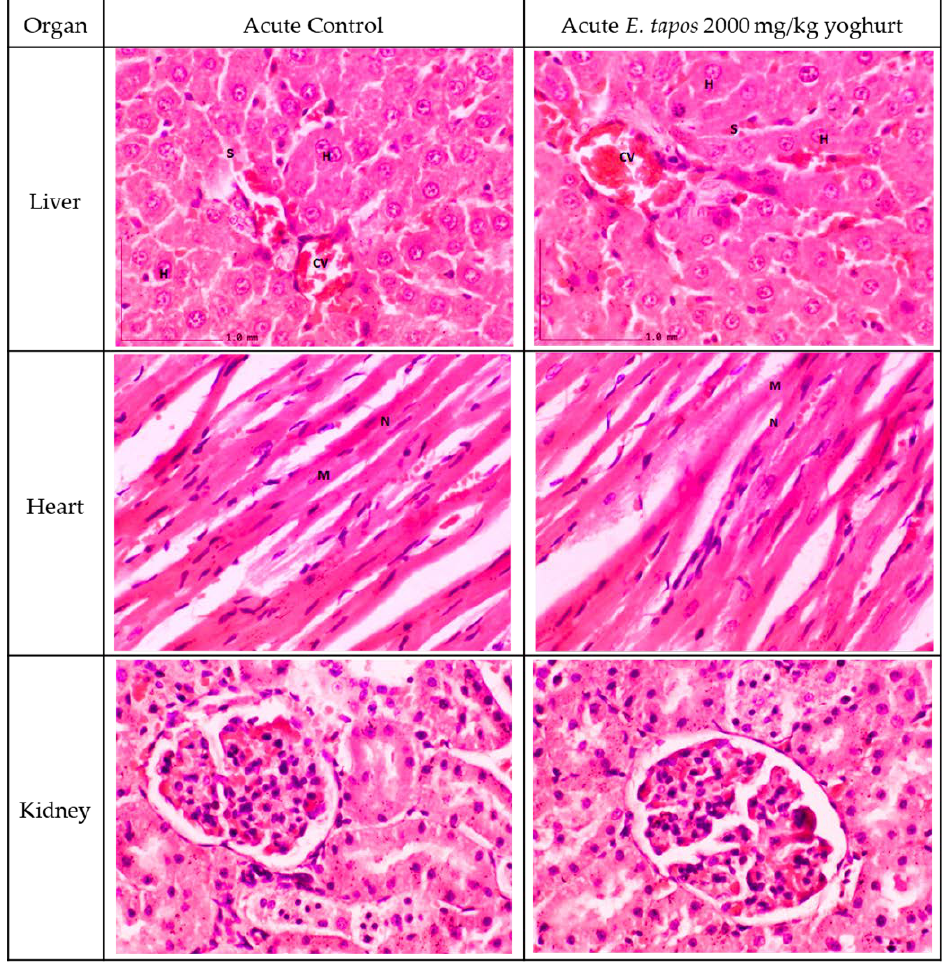
Figure 1. Histology section of acute toxicity study. The liver section shows standard strands of hepatocytes (H), sinusoids (S), and central vein (CV). It shows 0% of biopsied hepatocytes affected. The liver grading score was recorded as 0 due to absence of steatosis, lobular inflammation, and hepatocyte ballooning. The heart histological section shows normal heart architecture, and no inflammation was observed. Myocardium (M) and nucleus (N). The kidney histology showed no abnormal lesion or tubular dilation. Renal corpuscle appeared normal. No abnormalities were observed in kidney histology